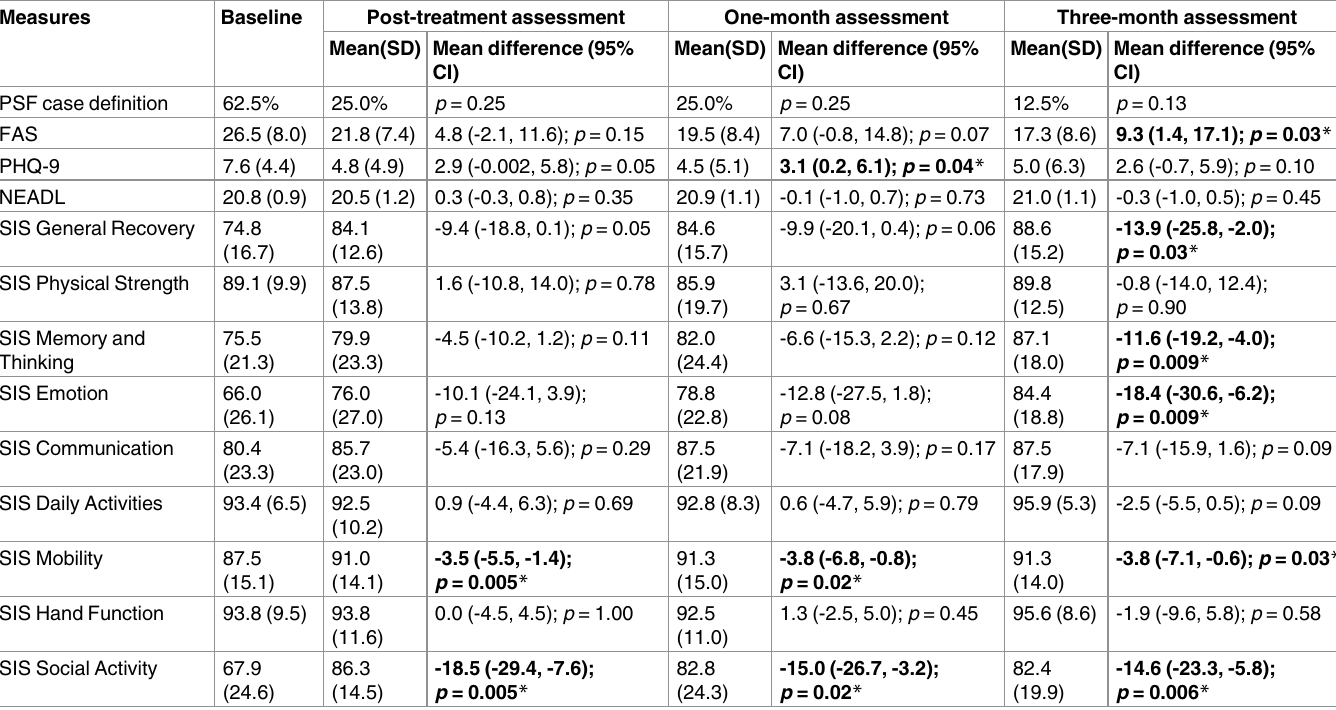
Table 5. Clinical outcomes at baseline and post-treatment assessments (n = 8).